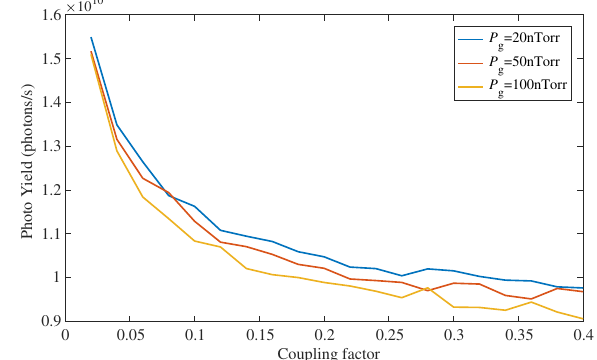
FIG. 22. Photon yield with varying gas pressure and coupling